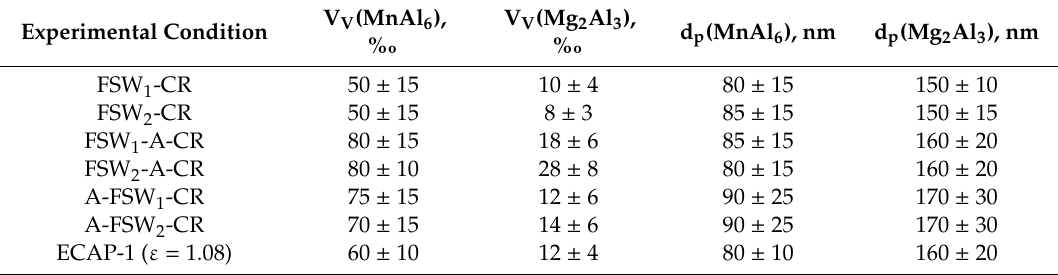
Table 4. Quantitative evaluation of the MnAl 6 dispersoids, Mg 2 Al 3 particles, and (Fe,Mn) 3 SiAl 12 intermetallic particles.